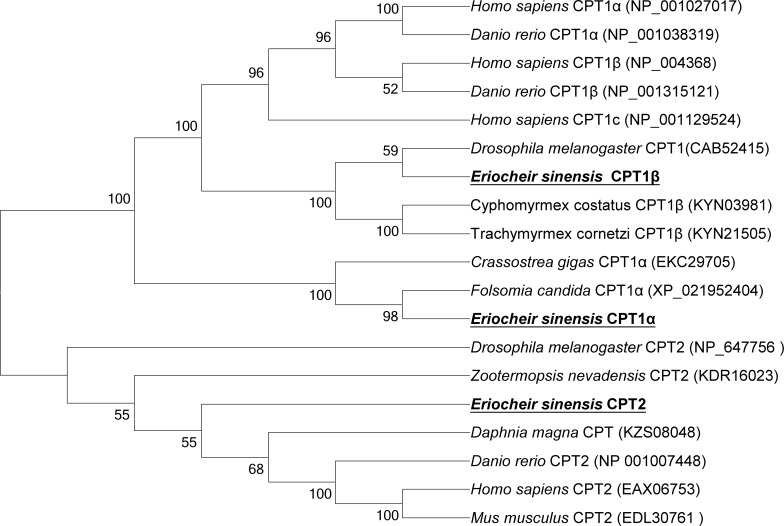
Phylogenetic tree comparing the deduced amino acid sequences of E. sinensis CPT family members with homologs from various organisms.The tree was constructed using the neighbour-joining method with MEGA 6.0, and bootstrap values supporting branch points are expressed as the percentage of 1000 replicates.